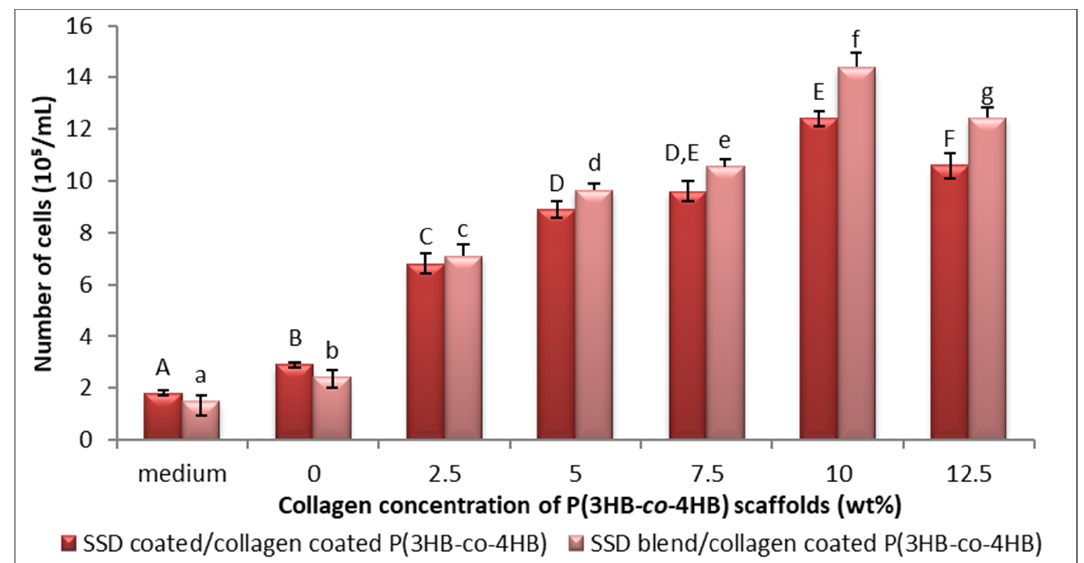
Figure 7. Proliferation of L929 cells on the SSD coated/collagen coated P(3HB- co -4HB); SCCC and SSD blend/collagen coated P(3HB- co -4HB); SBCC scaffolds. Data represent means ± SD ( n = 3). Mean data accompanied by different alphabets as of SCCC scaffolds (A–F) and SBCC scaffolds (a–g) indicates significant difference within each respective group (Tukey’s HSD test, p < 0.05).